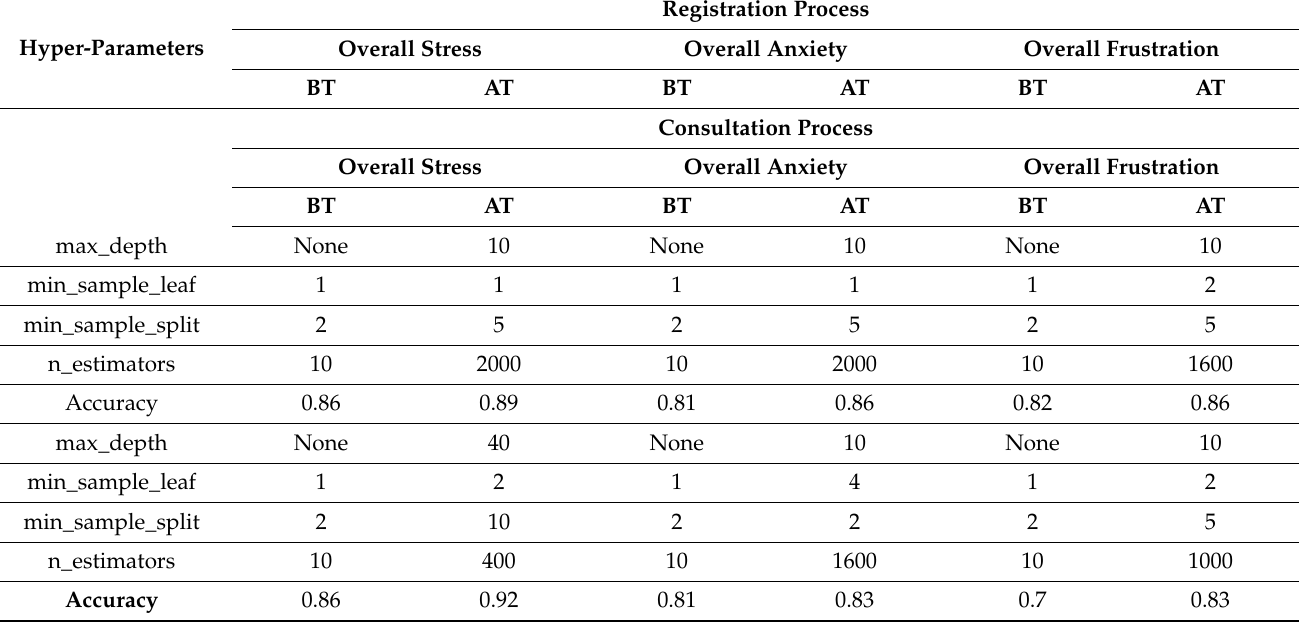
Table 6. Machine learning hyper-parameter values and accuracy